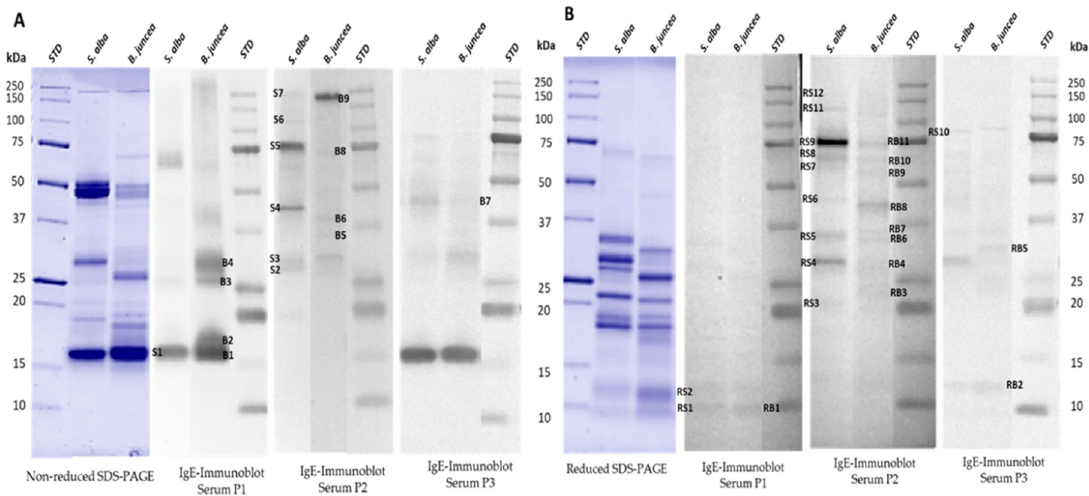
Figure 5. Identification of mustard IgE-binding protein bands for in gel-tryptic digestion and LC-MS / MS analysis. Protein extracts from S. alba AC Pennant and B. juncea AC Vulcan were separated under non-reducing ( A ) and reducing ( B ) conditions and immunoblotted using sera P1, P2, and P3. STDs are protein MW markers.